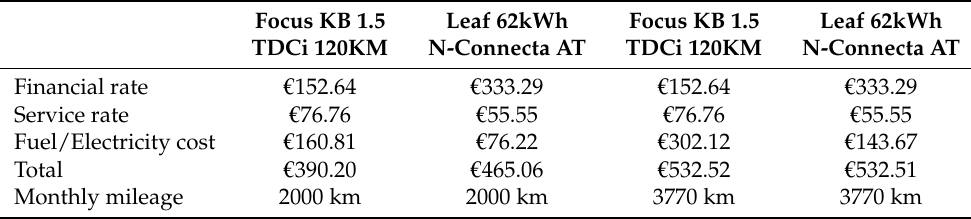
Table 6. TCO comparison for the B segment